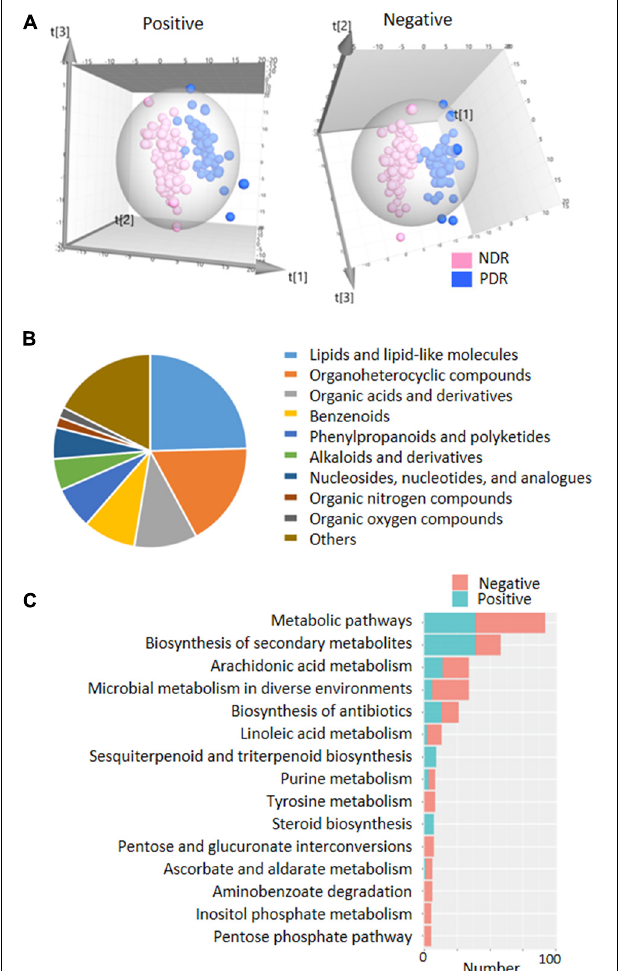
FIGURE 3 | | Fecal metabolic profiles in patients with and without proliferative diabetic retinopathy. (A) The three-dimensional PLS-DA score plots of the two groups. (B) The classification of significantly altered metabolic features. (C) The enriched KEGG pathways of altered metabolic features. PDR, proliferative diabetic retinopathy; NDR, diabetic patients without retinopathy; PCA, principal component analysis; PLS-DA, partial least squares discriminate